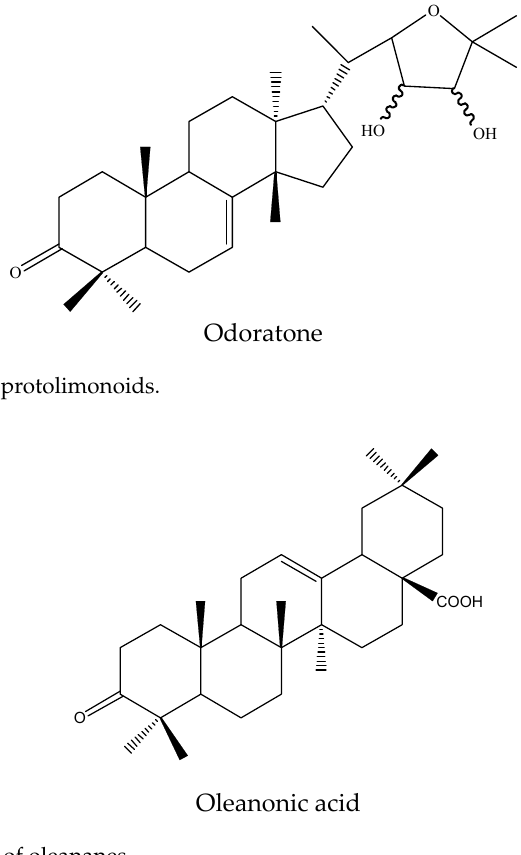
Figure 19. The structures of dammaranes.